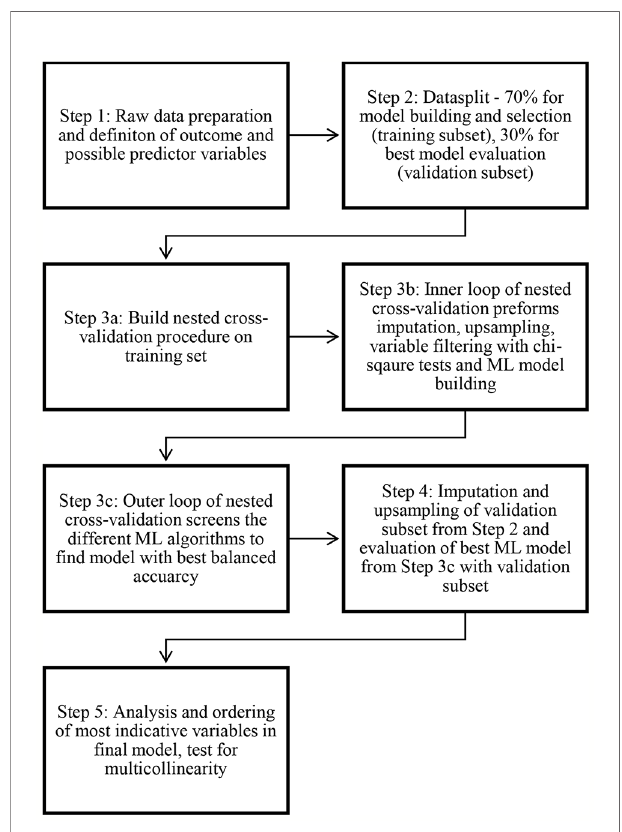
FIGURE 1 | Data processing and statistical